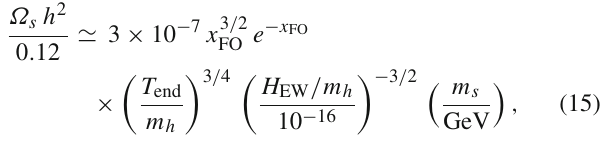
The same conclusion can be extracted from the lower panel of Fig. 1, where the particle physics parameters are fixed, m s = 20 GeV (dashed lines) and 50 GeV (solid lines), and λ hs = 10 − 3 (blue lines) and 10 − 2 (black lines) while we scan over the cosmological parameters. The left red band corresponds to a scenario which is not MD ( H EW / m h < 10 − 16 ), whereas the lower left corner